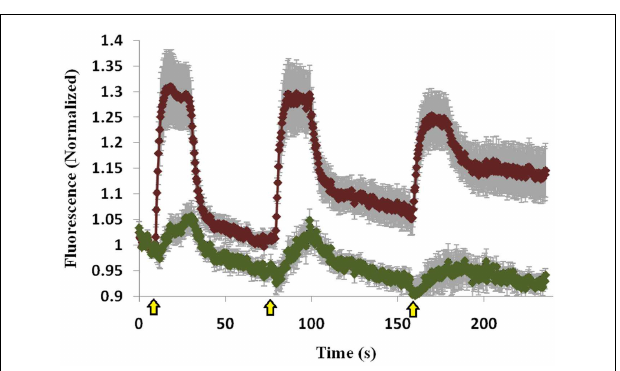
FIGURE 6 | Co-translocation of Doc2B wt –mRFP and Munc13-1 H567K –EGFP . Quantification graph of theTIRF experiment demonstrating translocation of Doc2B wt and low translocation of Munc13-1 H567K ( n = 14). No accumulation of Munc13-1 H567K is detected. Yellow arrows indicate KCl